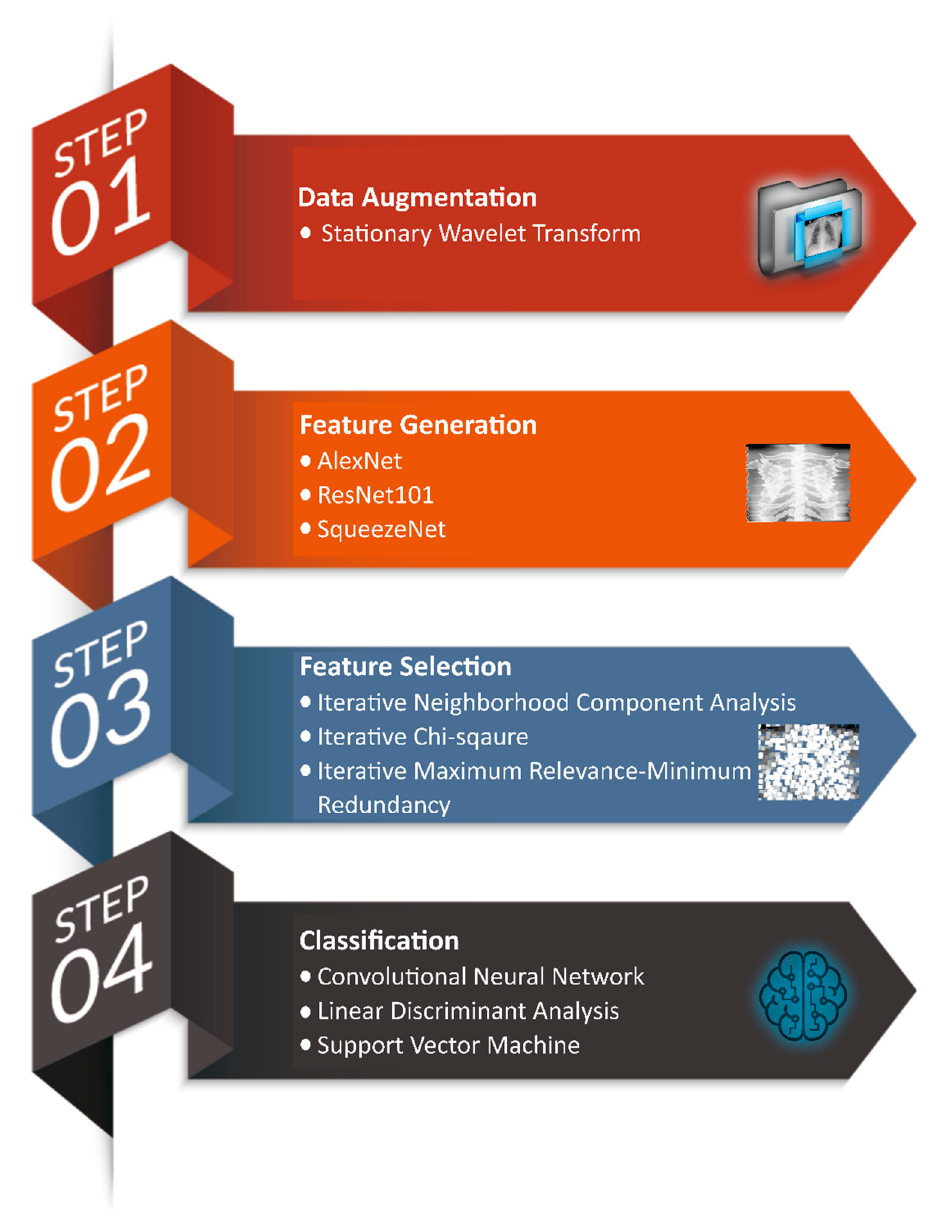
Figure 1. Workflow of the proposed system.